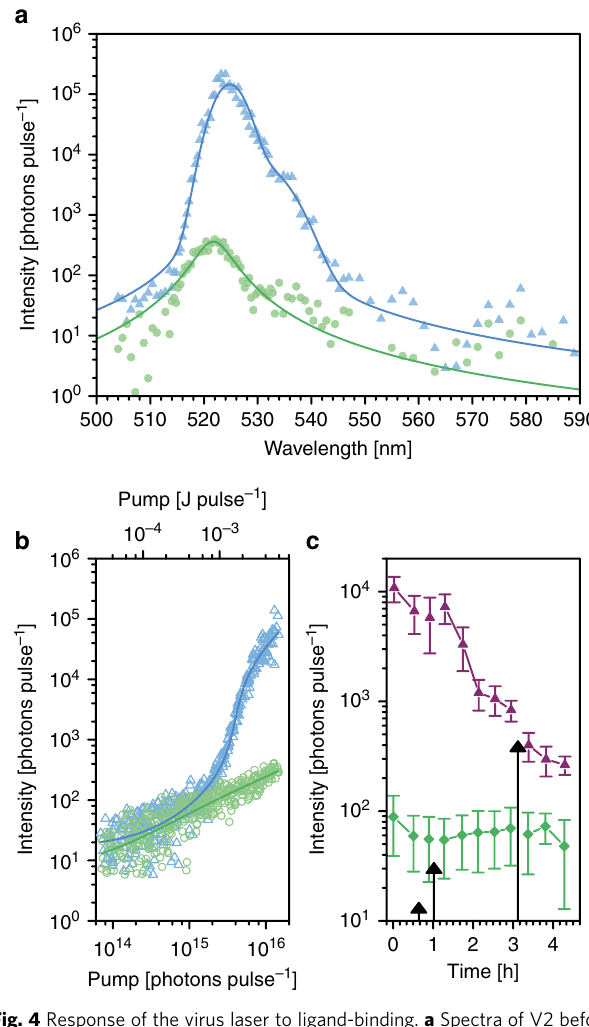
Fig. 4 Response of the virus laser to ligand-binding. a Spectra of V2 before (cyan) the addition of cp-mAb at 1.3 × 10 16 photons pulse − 1 and after (light green) the addition of the antibody at 1.4 × 10 16 photons pulse − 1 . Each scatter point is the mean of four measurements at each wavelength and the curves are fi ts to the sum of two Voigt peak functions (dark blue) and a Lorentzian peak function (green). b Threshold behaviour of V2 before and after the addition of cp-mAb, same colours as ( a ). Lines represent individual fi ts of the data to equation (26). c Time-dependence of the intensity at 523.5 nm at pump energies initially above threshold at 1.3 × 10 16 photons pulse − 1 ± 4.7% (purple) and below threshold at 1.6 × 10 15 photons pulse − 1 ± 4.4% (green). The concentration of cp-mAb, which is a ligand bound by M13, in the gain medium after mixing increases in steps from 0 fmol mL − 1 to 9 fmol mL − 1 , 29 fmol mL − 1 and then 90 fmol mL − 1 . The arrows indicate when cp-mAb was added to the reservoir, and the lengths of the arrows are proportional to the amount added to the reservoir at each step. The squares and error bars represent the mean and standard deviation, respectively, of 7 measurements taken at each point in the time series. The variation in intensity at each time point is caused by small fl uctuations in the pump energy and random variations in the response of the intensity to pumping. See Supplementary Figs. 7, 8 and 9 for all of the collected data. Source data are provided as a Source Data fi